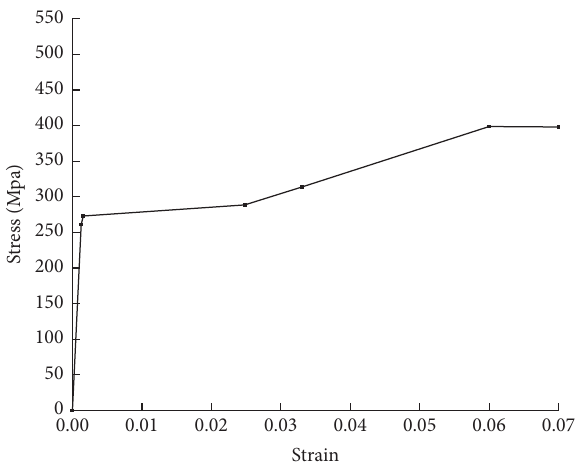
Figure 4: Stress-strain curve of the steel Q355B.